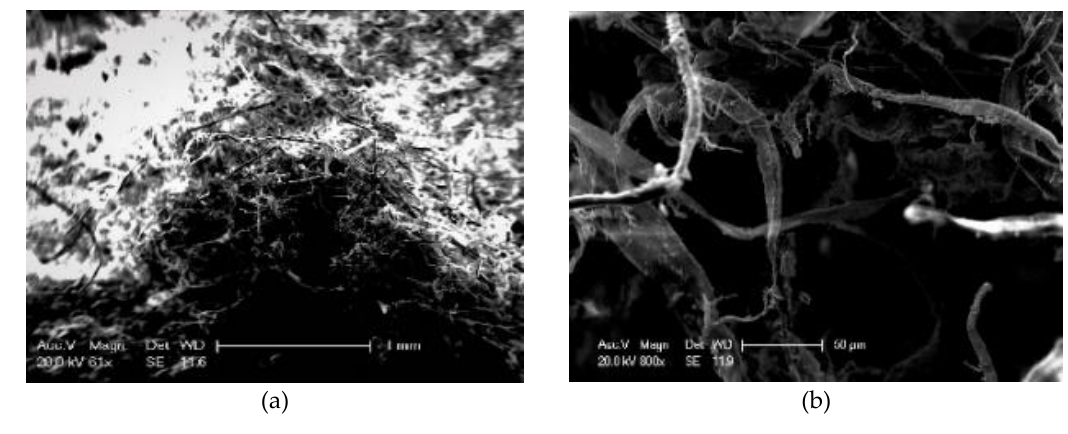
Figure 14. Micro image of LF: ( a ) 60×; ( b ) 800×.